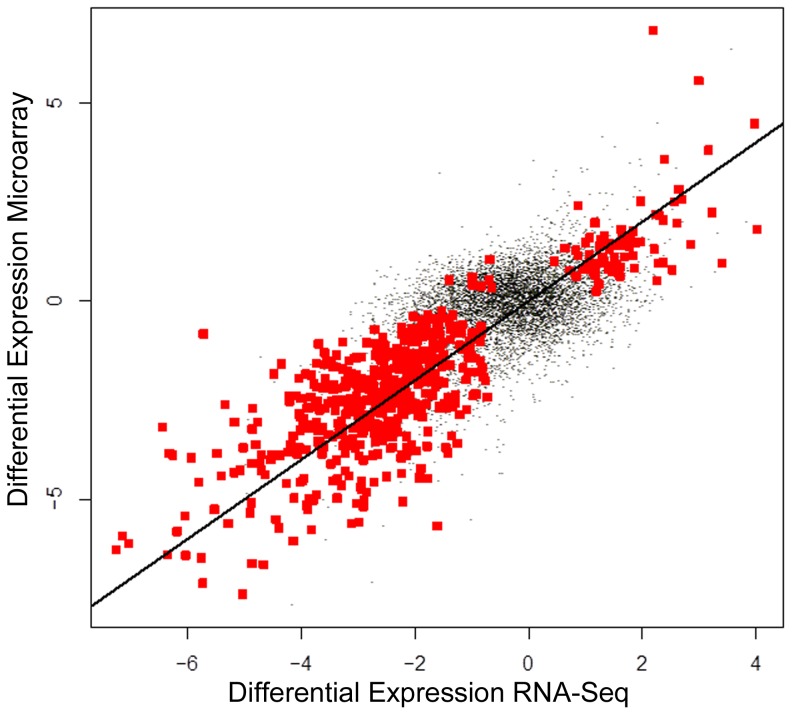
Differential Expression is Concordant Between Technologies.Estimates of differential expression obtained using RNA-Seq and Microarray are correlated. Points represent genes, located based on estimates of differential expression using RNA-Seq and Microarray. Red points represent genes for which FDR<0.2. The line corresponds to perfect agreement between the technologies.